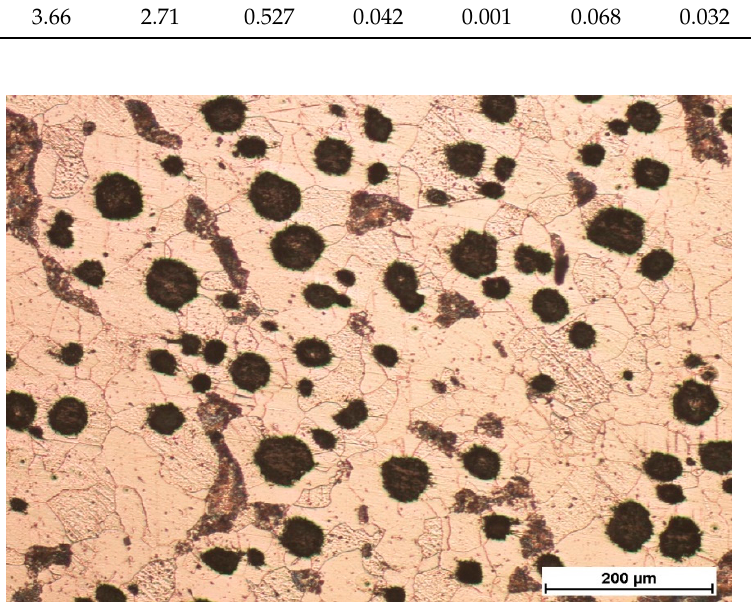
Table 1. The EN GJS-350-22 ductile cast iron chemical composition. Chemical Composition, wt.%